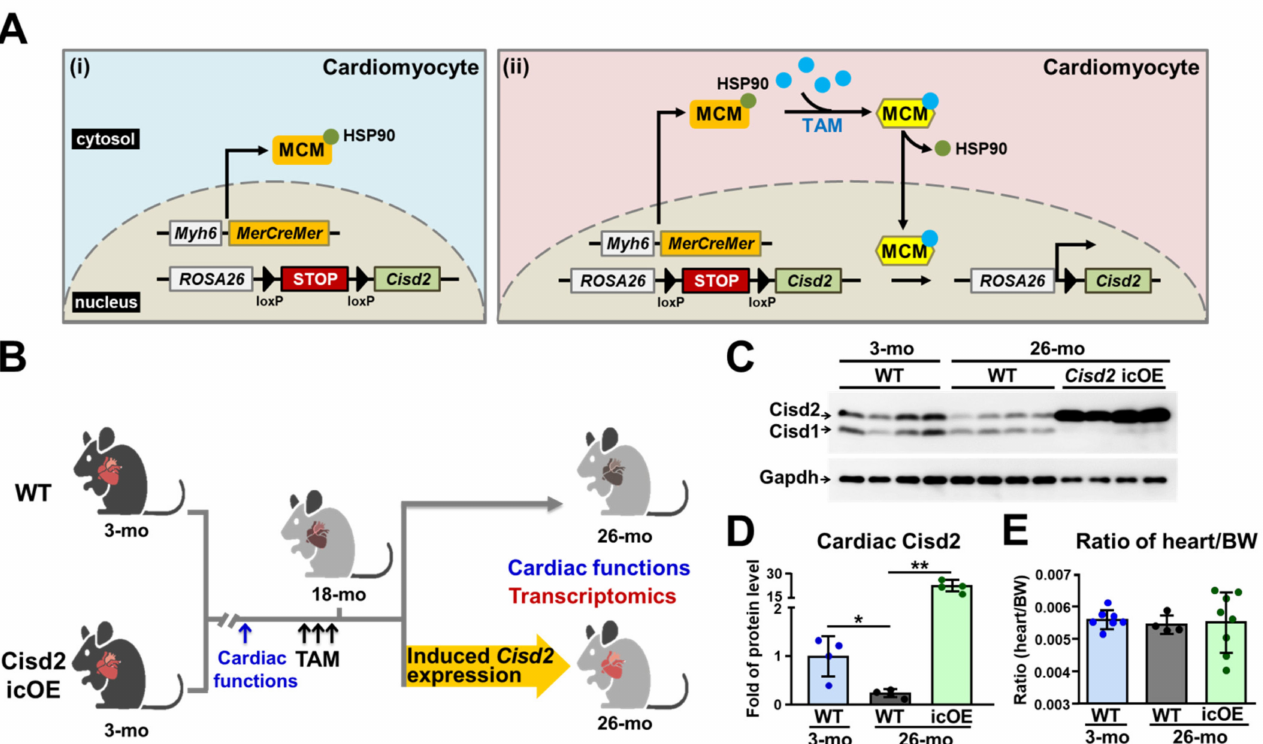
Figure 1. Schematic illustration of the inducible and cardiac-specific overexpression of Cisd2 ( Cisd2 icOE) in transgenic mice. ( A ) The strategy used for cardiac-specific and tamoxifen (TAM)-inducible overexpression of Cisd2 in the mice. The R26-Cisd2KI/+ mice were crossed with mice carrying the cardiac-specific expression of tamoxifen-inducible Cre recombinase ( α MHC-MerCreMer ). (i) In the absence of tamoxifen, the MerCreMer (MCM) is sequestered by heat shock protein 90 (HSP90) and retained in the cytoplasm. (ii) Under the presence of tamoxifen, the MCM complex is disassociated from HSP90 and is then translocated into the nucleus to carry out the Cre/loxP-mediated deletion of the STOP cassette; α MHC , α -myosin heavy chain promoter. ( B ) The flow chart of tamoxifen treatment. The cardiac functions were monitored at 3 and 18 months of age before tamoxifen injection. At 18 months of age, both the WT control ( R26-Cisd2KI/+ ) and the Cisd2 icOE ( R26-Cisd2KI/+; α MHC-MCM ) mice had tamoxifen administered by intraperitoneal injection (40mg/kg body weight on three consecutive days). Cardiac function analysis was performed at 26 months of age, namely 8 months after tamoxifen injection. ( C , D ) Western blot analysis and quantification of the expression levels of Cisd2 in the hearts obtained from 3-mo WT, 26-mo WT, and 26-mo Cisd2 icOE mice. ( E ) Ratio of heart weight and body weight (BW). The data are presented as the means ± SD and analyzed by one-way or two-way ANOVA with Bonferroni multiple comparison tests; * indicates p < 0.05; ** p < 0.005. There were at least five mice in each group. The figure was created with